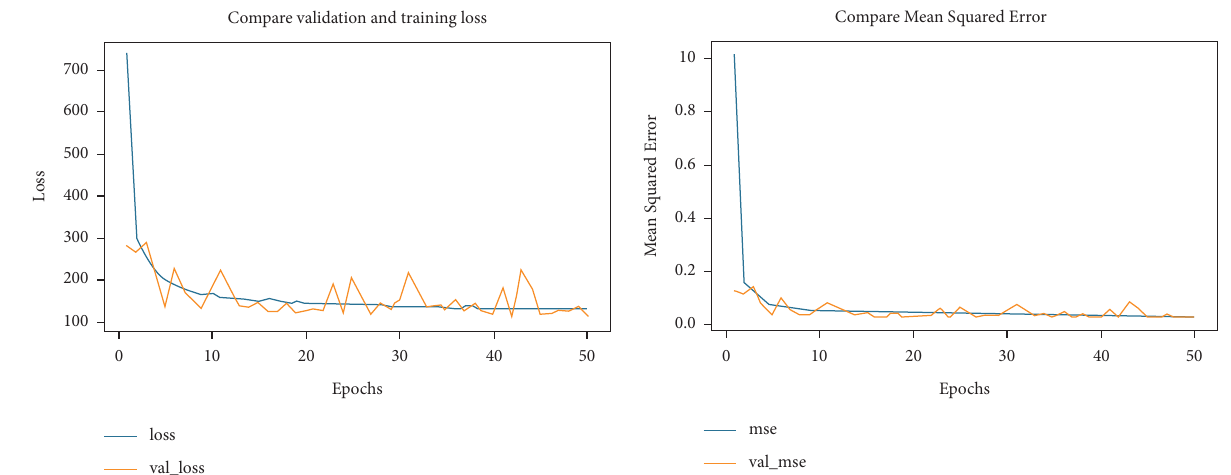
Figure 9: Validation and training